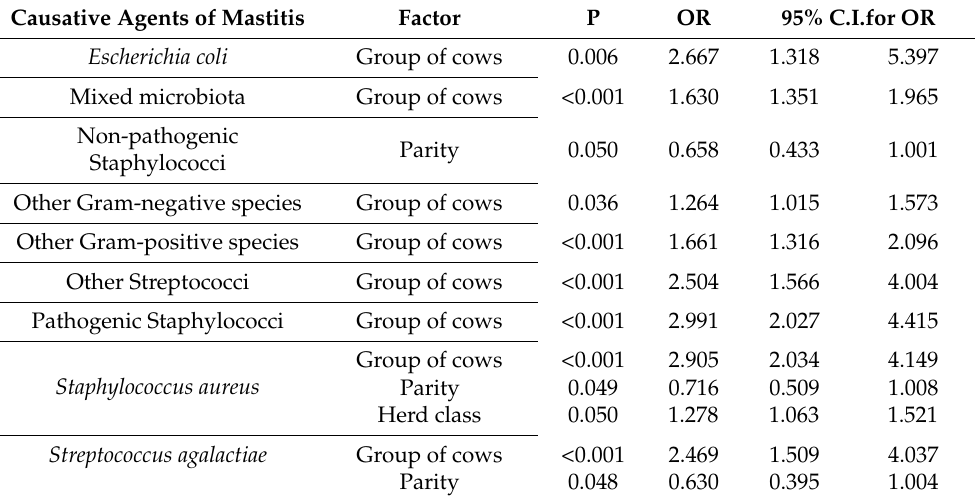
Table 3. Odds ratio for association of stillborn calves with mastitis pathogens and parity of dairy cows.